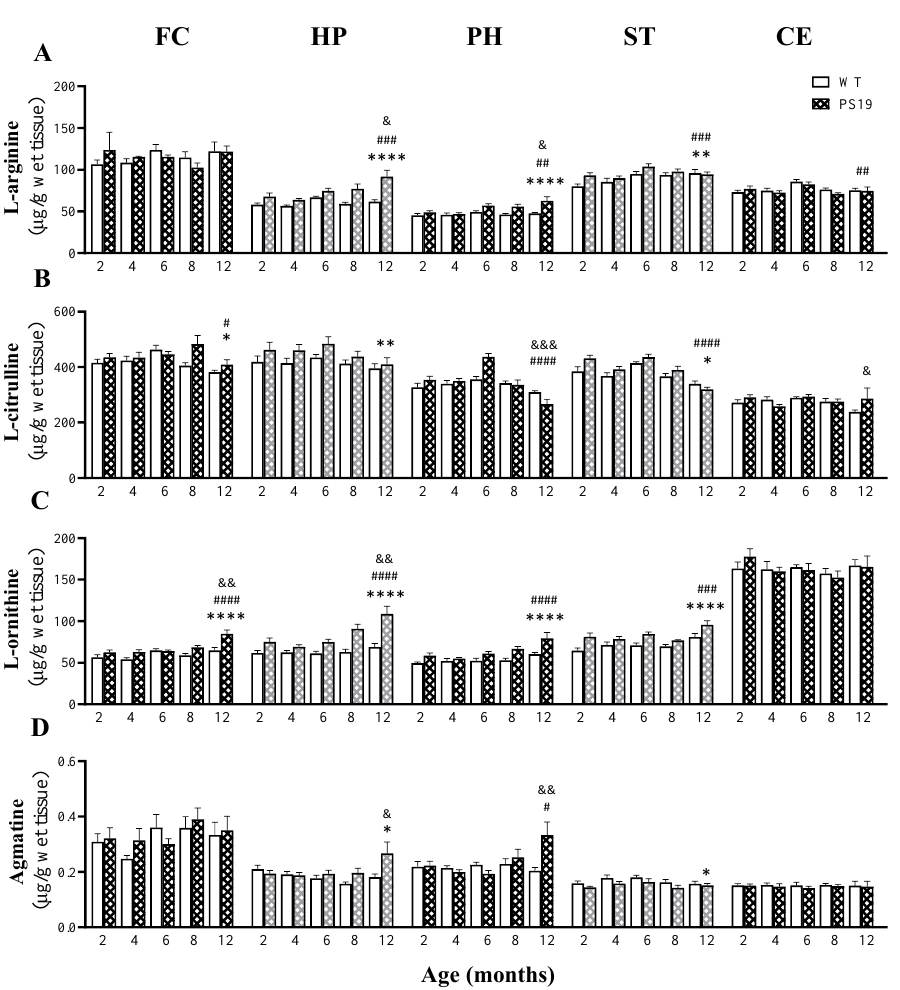
Figure 2. Mean ( ± SEM) levels of L-arginine ( A ) and its three direct metabolites L-citrulline ( B ), L-ornithine ( C ) and agmatine ( D ) in the frontal cortex (FC), hippocampus (HP), parahippocampal region (PH), striatum (ST) and cerebellum (CE) of wildtype (WT) and PS19 mice at 2, 4, 6, 8 and 12 months of age ( n = 7–9/genotype/age). & indicates a significant genotype and age interaction at & p < 0.05, && p < 0.01 or &&& p < 0.001. # indicates a significant age effect at # p < 0.05, ## p < 0.01, ### p < 0.001 or #### p < 0.0001. * indicates a significant genotype effect at * p < 0.05, ** p < 0.01 or **** p < 0.0001.